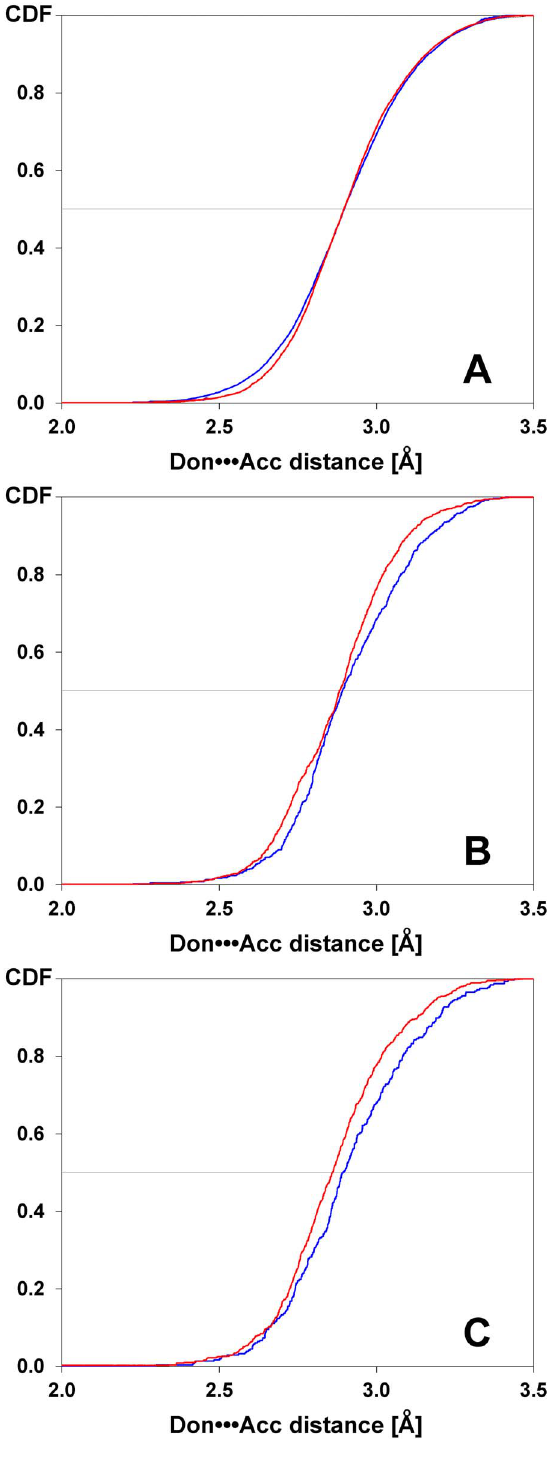
Figure 2. Cumulative distributions of NH NNN O (blue) and O NNN HN (red) intermolecular hydrogen bonds identified in protein complexes with non-halogenated (A, LH), fluorinated (B, LF) and otherwise halogenated ligands (C, LX). See Table 2 for